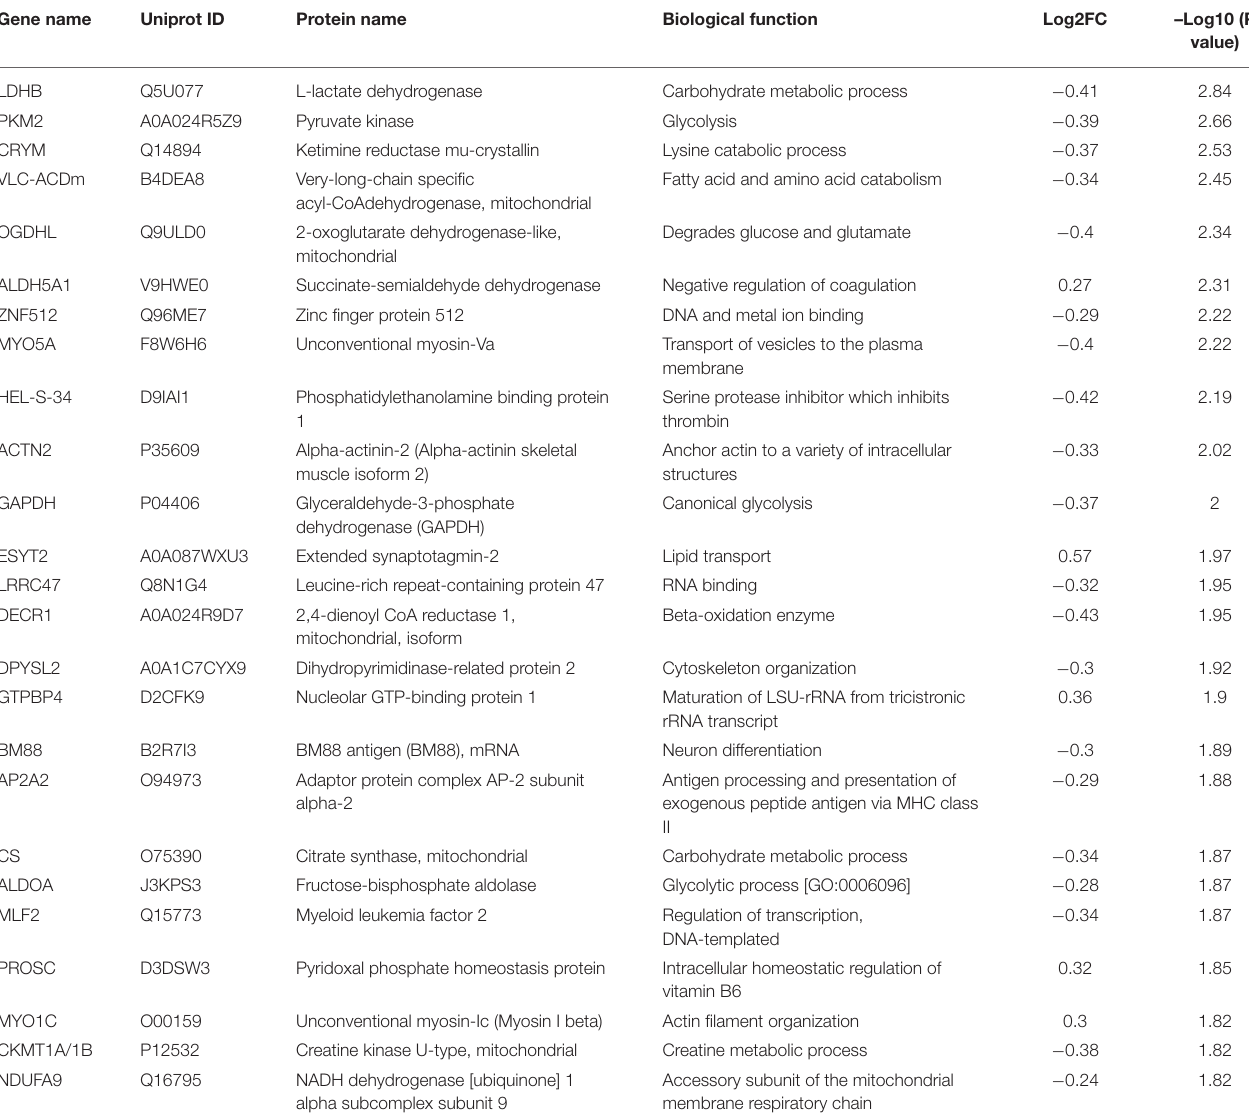
TABLE 5 | List of Top 25 proteins significantly regulated in the inferior frontal gyrus cerebrovasculature of low vs. high CAA [AD]